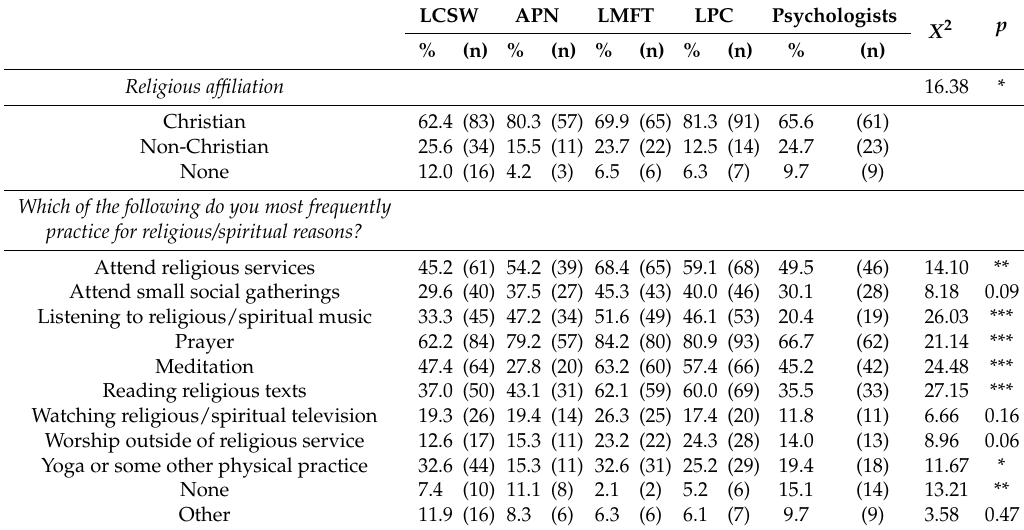
Table 4. Religious Affiliation and Practices among Helping Professions in